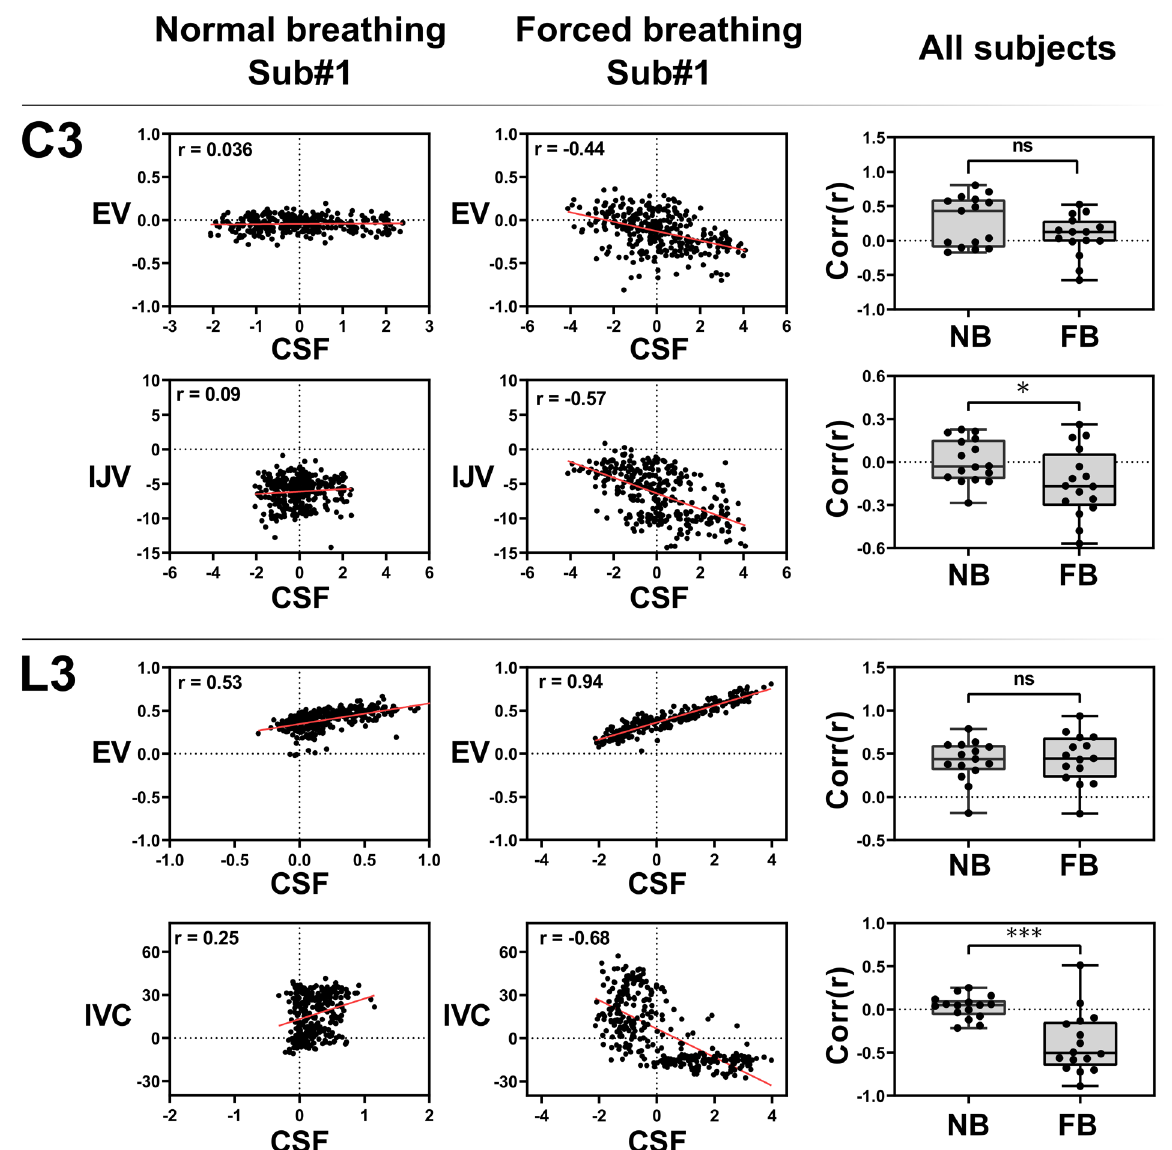
Figure 5. Correlation between CSF and venous flow. Scatter plots show relation between C3-CSF v/s EV, C3-CSF v/s IJV, L3-CSF v/s EV, L3-CSF v/s IVC during normal breathing (left column) and forced breathing (middle column) for subject #1. Red lines represent the linear regression and ‘r’ is the correlation coefficient. Right column displays the Pearson’s correlation coefficient of all subjects and p-values of student’s t-tests. Significance is reached for C3-CSF v/s IJV and L3-CSF v/s IVC but not for C3-CSF v/s EV and L3-CSF v/s EV. C3 = cervical level 3, L3 = lumbar level 3, EV = epidural veins, IJV = internal jugular vein, IVC = inferior vena cava, Corr(r) = Pearson’s correlation coefficient, NB = normal breathing, FB = forced breathing, ns = not significant, Sub =